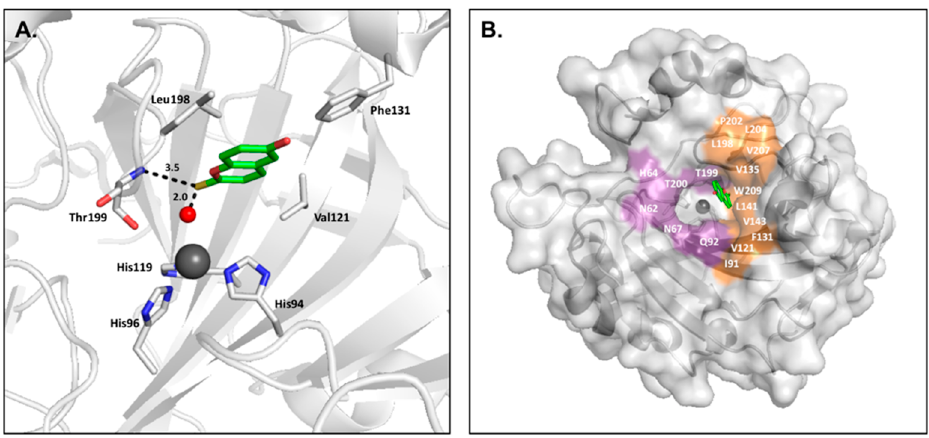
Figure 10. ( A ) CA ΙΙ ( gray ) in complex with 6-hydroxy-2H-chromene-2-thione ( green ) (PDB:4WL4); ( B ) Surface representation of CA II in complex with thioxocoumarin inhibitor [55]. ( B ) Surface representation of CA II in complex with thioxocoumarin inhibitor